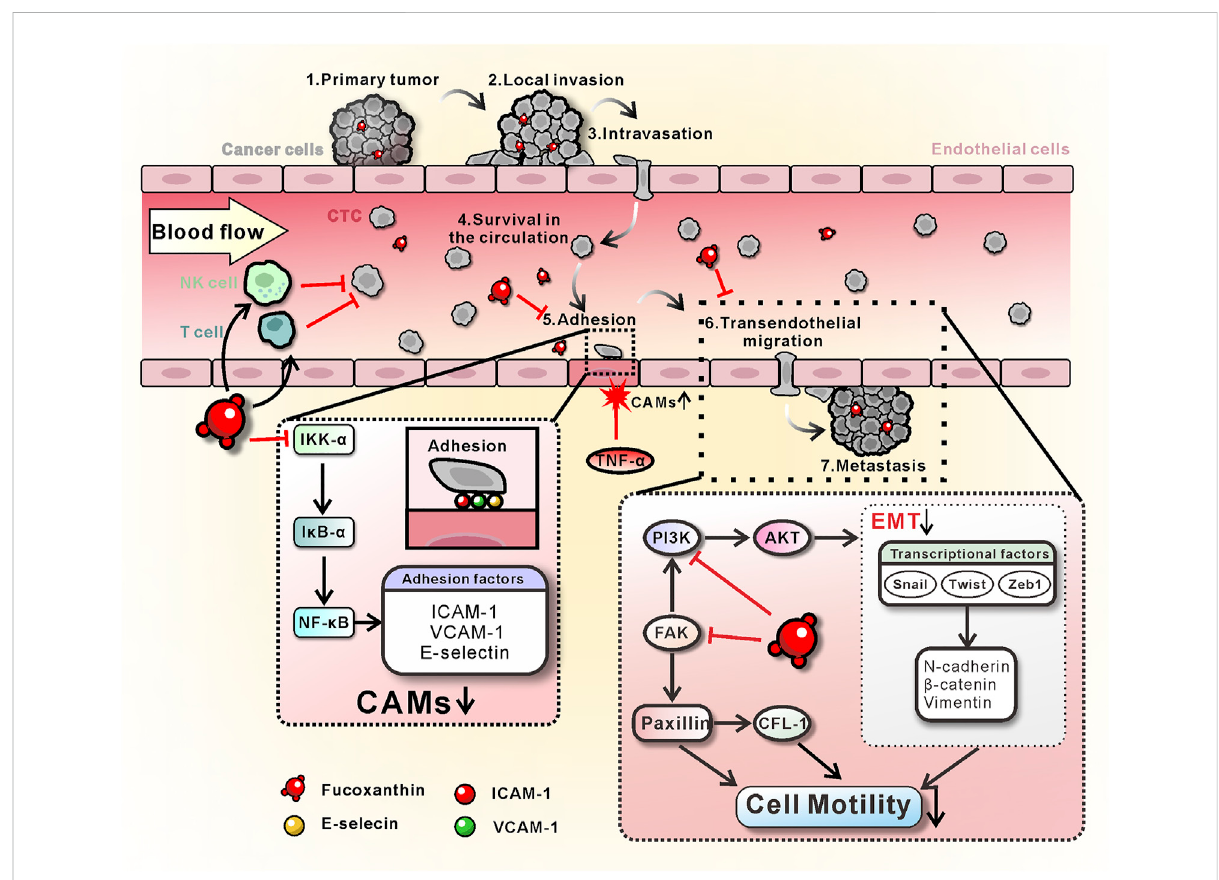
FIGURE 8 Schematic diagram of the mechanism of Fx prevents breast cancer metastasis. On the one hand, Fx inhibits TNF- α -induced CAMs (ICAM-1, VCAM-1, and E-selectin) expression on endothelial cells by inhibiting the NF- l B signaling pathway, resulting in the interruption of CTCs adhesion to the vascular endothelium. On the other hand, Fx reduces EMT and cancer cell motility by regulating PI3K/AKT and FAK/Paxillin signaling pathways, resulting in the inhibition of cancer cell transendothelial migration. Furthermore, Fx enhances antitumor immune responses by substantially increasing the subsets of Tc cells in the peripheral immune system. These bene fi cial effects of Fx collectively resulted in the suppression of CTCs- induced cancer